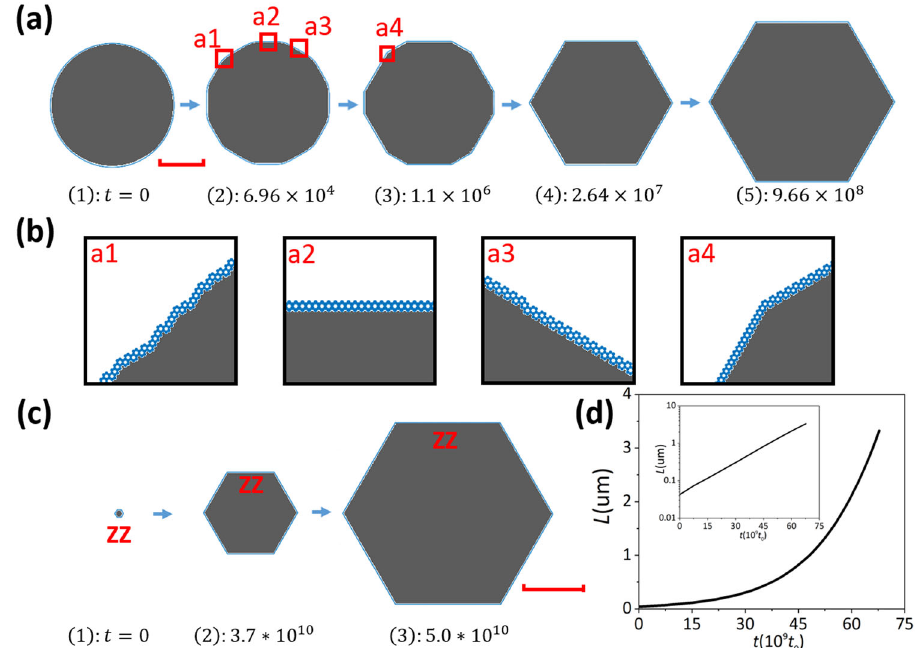
Fig. 3 Growth simulation of a graphene island. The simulation condition is μ = 0.2 eV and k B T = 0.1 eV. a Representative snapshots of a trajectory of KMC simulation for graphene growth. The evolution time is labeled below each snapshot in the unit of t 0 , where t 0 = h / k B T . The scale bar is 2.0 μ m for all snapshots. b Atomic edge structures in simulation ( a ), a1 is a rounded corner near the crossover region from zigzag edge to armchair edge during the initial stage of the evolution, a2 is a straight zigzag edge, a3 is a straight armchair edge, and a4 is a sharp corner between a zigzag edge and an armchair edge, respectively. c Representative snapshots of a growth simulation of zigzag graphene island. The evolution time is labeled below each snapshot in the unit of t 0 , where t 0 = h / k B T . The scale bar is 1.0 μ m for all snapshots. d Plot of the island size in c with growth time by linear and logarithmic scale